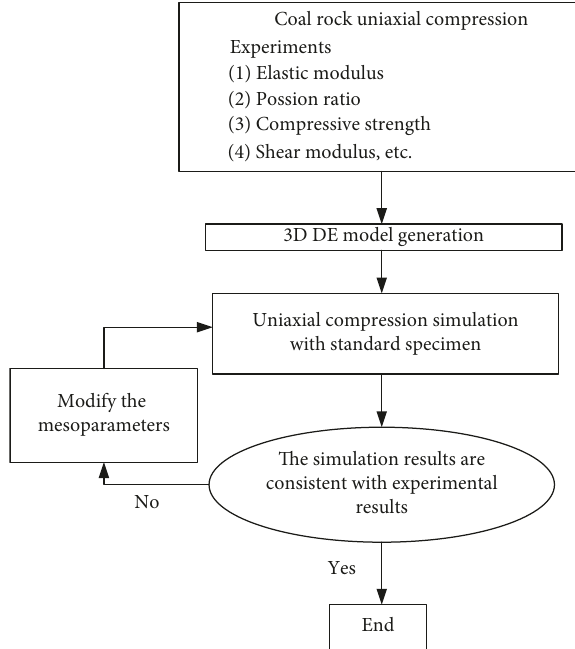
Figure 14: Calibration procedures for mesoparameters of